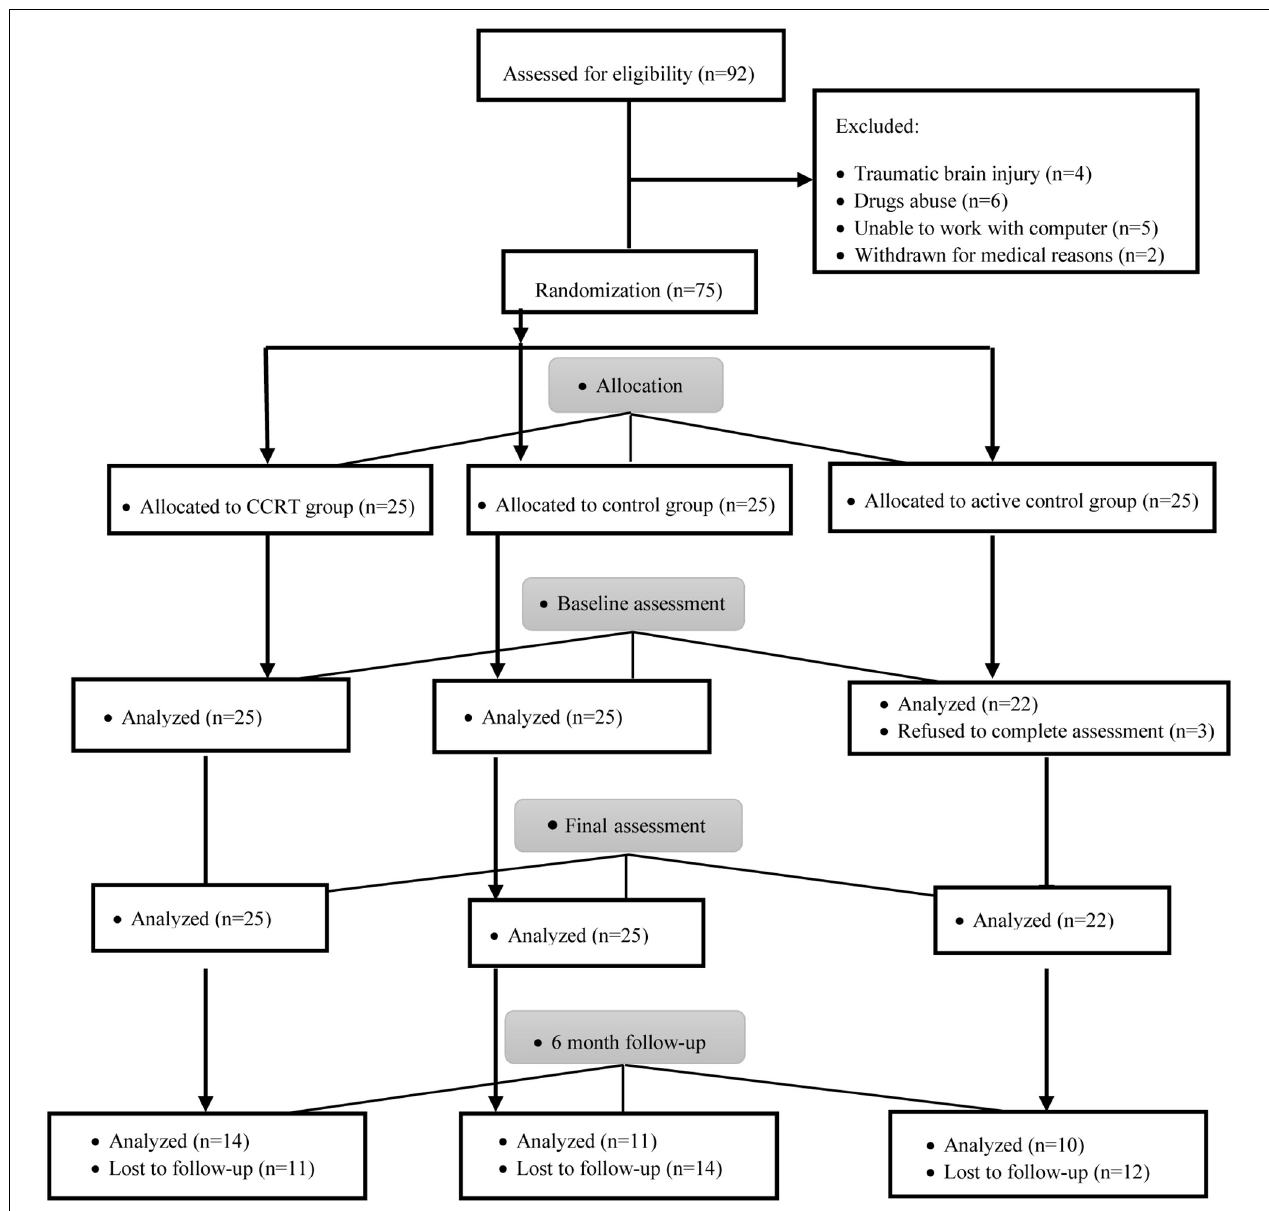
FIGURE 2 | CONSORT flow diagram of patients through the study.